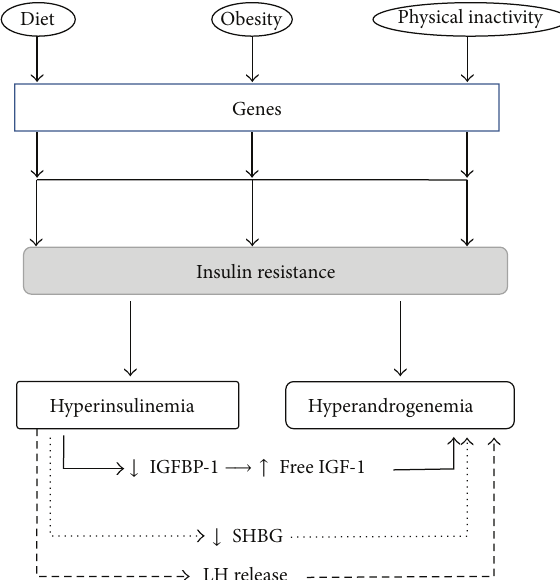
Figure 2: Connections between insulin resistance, hyperinsuline- mia, and hyperandrogenism. FSH = follicle stimulating hormone, IGF = insulin-like growth factor, IGFBP = insulin-like growth factor binding protein, LH = luteinizing hormone, and SHBG = sex hormone binding